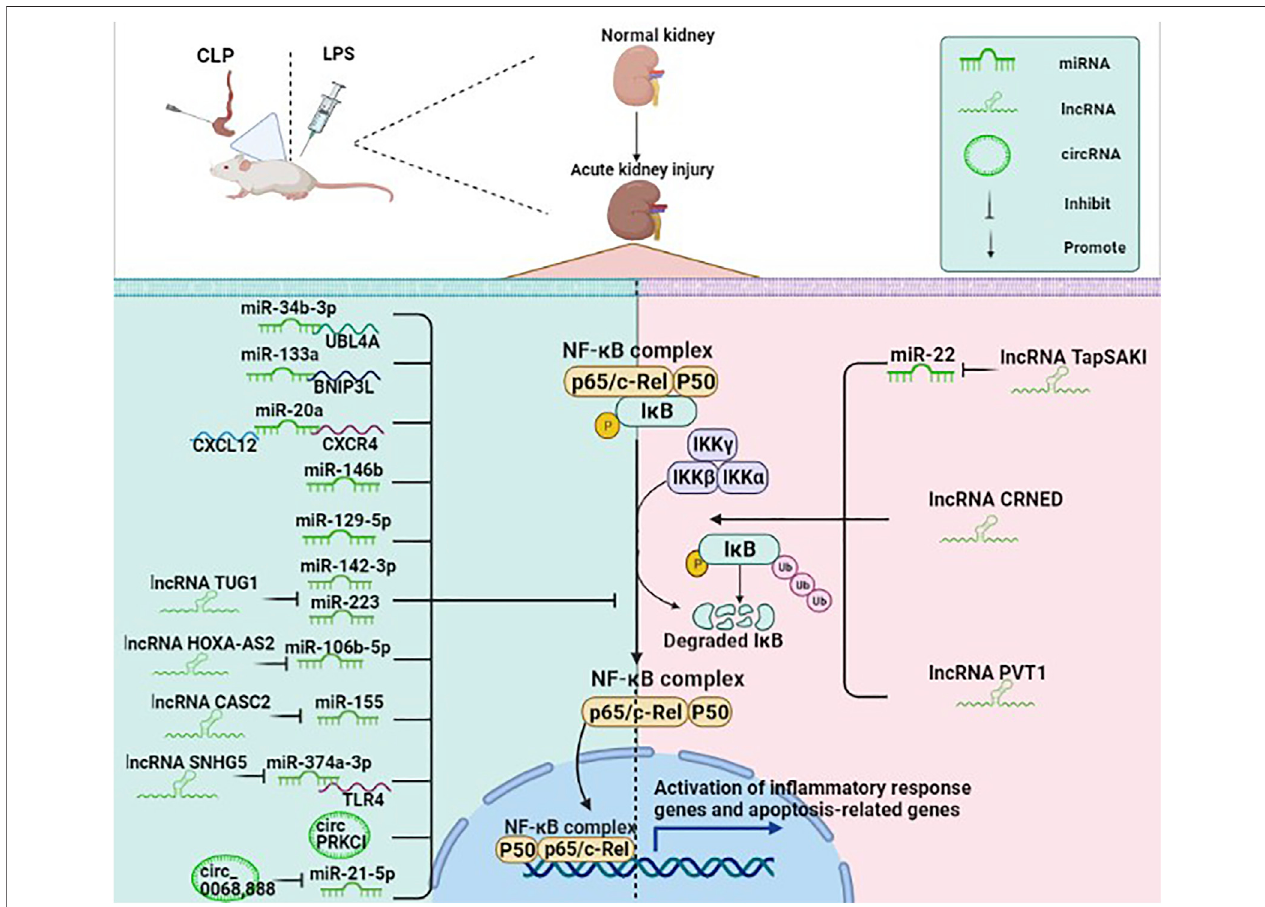
FIGURE 3 | ncRNAs (mainly miRNAs, lncRNAs, circRNAs) participate in the NF- κ B pathway in SA-AKI. NF- κ B is a vital transcription factor in the cytoplasm in an inactivestate,composedofthedimericp50/p65andanotherinhibitorysubunitI κ B.WhenI κ BiscatalyzedbyI κ Bkinase,itundergoesphosphorylationanddegradation, causing NF- κ B to rapidly activate, while the activated NF- κ B enters the nucleus and binds to numerous gene promoters, regulating various pathological processes. ncRNAs are involved in the pathological process of SA-AKI by regulating the NF- κ B signaling pathway.